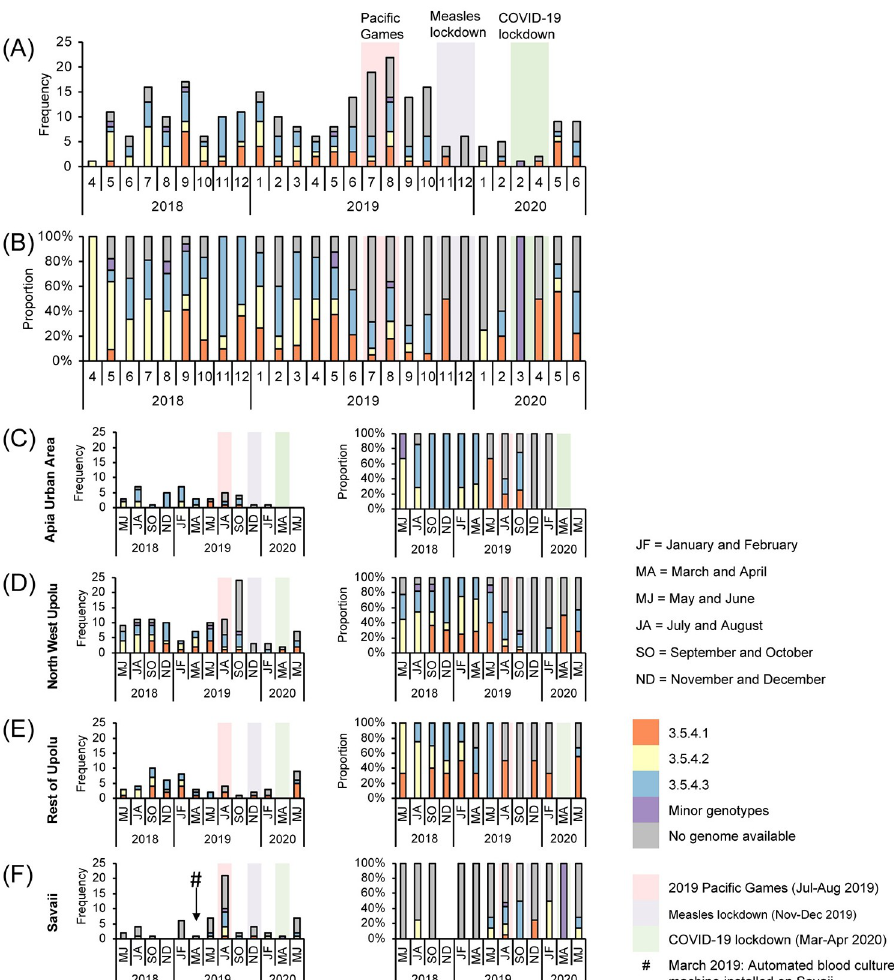
Fig 4. Bar graphs depicting the number and proportion of blood culture-confirmed cases of typhoid fever in Samoa over time from April 27, 2018 through June 9, 2020 by genotype/sub-lineage. (A-B) The frequency and proportion of acute cases (N = 260) occurring each month are colored by genotype/sub-lineage (n = 172) or greyed if no genome was available (n = 88). Genotype 3.5.4 sub-lineages 1–3, comprising a total of 166/172 sequenced isolates from acute cases, are identified as orange, yellow, and blue bars, respectively. Minor genotypes (purple bar) include genotype 4.1 (4/186), genotype 3.5.3 (1/186), and one genotype 3.5.4 outlier (1/186) that did not fall into one of the three sub-lineages. (C-F) The frequency and proportion of acute cases occurring over 2-month intervals in each census region. Three major events impacting population mobility–increases during the 2019 Pacific Games in Nov-Dec 2019, and restrictions during the measles lockdown from Nov-Dec 2019 [35] and COVID-19 lockdown from Mar-Apr 2020 [36]–are labeled as light red, light purple, and light green background colors, respectively, over the two-month time intervals